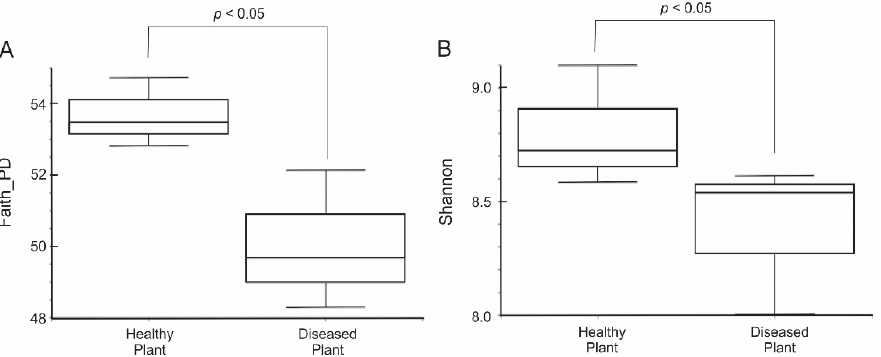
Figure 1. Low bacterial diversity in diseased field through alpha diversity analysis. ( A ) Faith’s phylogenetic diversity (H index: 3.85 and p < 0.05); ( B ) Shannon diversity index (H index: 3.86 and p < 0.05). Healthy plant: OK; diseased plant: NG.